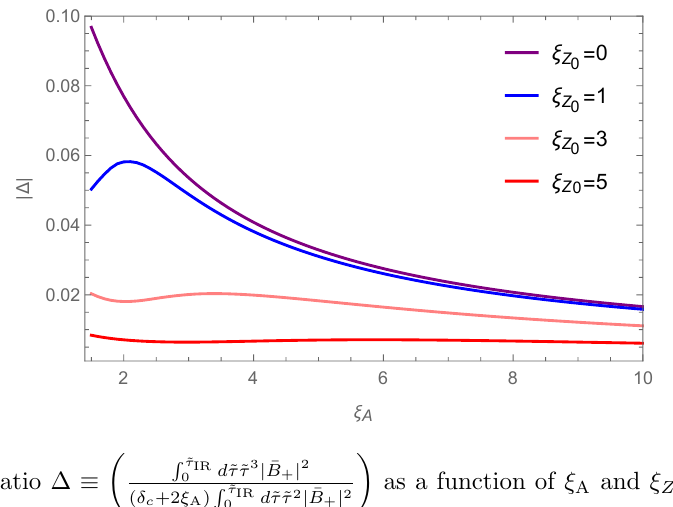
. Here ~ (cid:28) IR is the 0